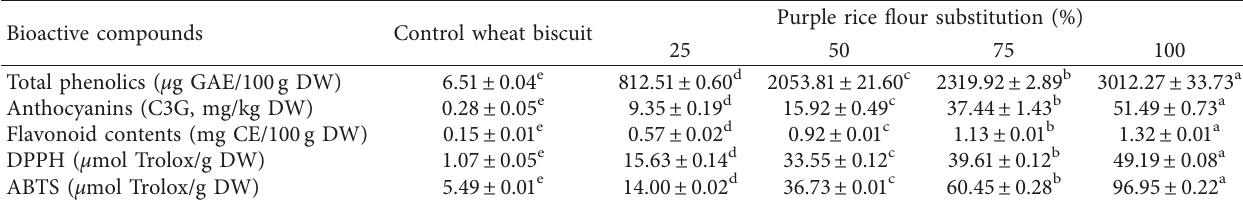
Table 5: Bioactive compound contents of the biscuits containing different levels of purple rice flours ∗